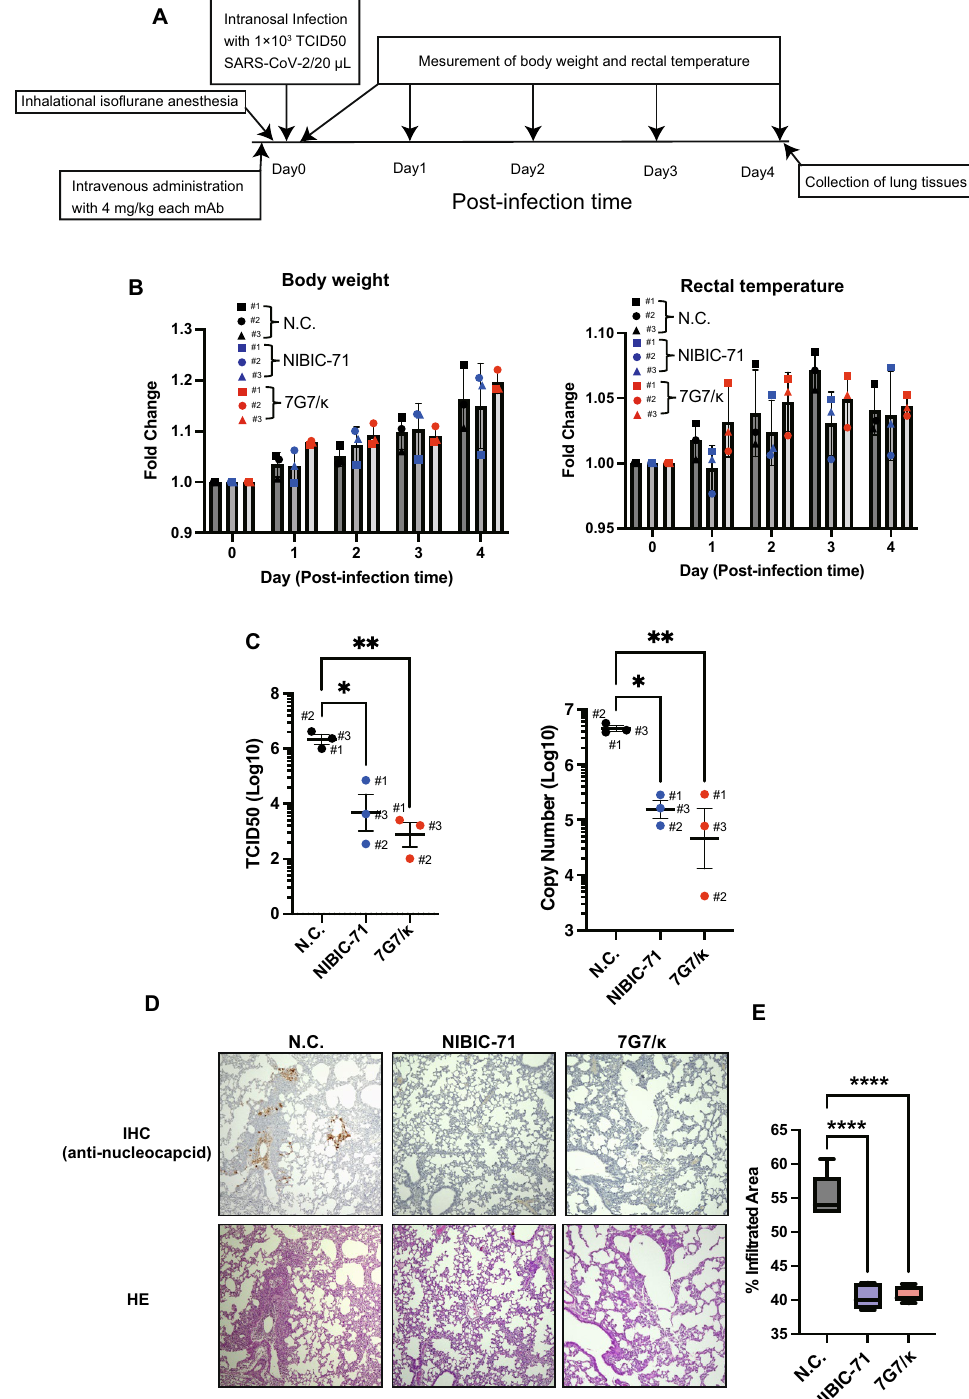
Figure 4. Analysis of in vivo neutralizing activity of NIBIC-71 and 7G7. Male 3-week-old Syrian hamsters that received 4 mg/kg of recombinant mAbs intravenously were infected with WT SARS-CoV-2 via the nasal route. ( A ) the schematic of in vivo infectious experiment. ( B ) Body weight (left) and rectal temperature (right) were monitored up to 4 days after infection (n = 3). Fold change is the value relative to before infection. ( C ) Viral load in the lung at 4 days after infection was shown as the means ± standard error of the mean for TCID50 (left) and copy number (right) (n = 3). ( D ) Histological analysis with IHC (N antigen) (upper) and HE staining (lower). SARS-CoV-2 was detected with an anti-nucleocapsid protein antibody. The brown staining indicated nucleocapsid (N antigens) of SARS-CoV-2. E. The proportion of the area with cellular infiltration was presented as mean ± standard error of the mean 15 . This value is the ratio of the HE-stained area to the whole area. These areas were obtained in 5 sections from each hamster. * P < 0.05; ** P < 0.01, **** P < 0.001 (ANOVA). TCID50, tissue culture infectious